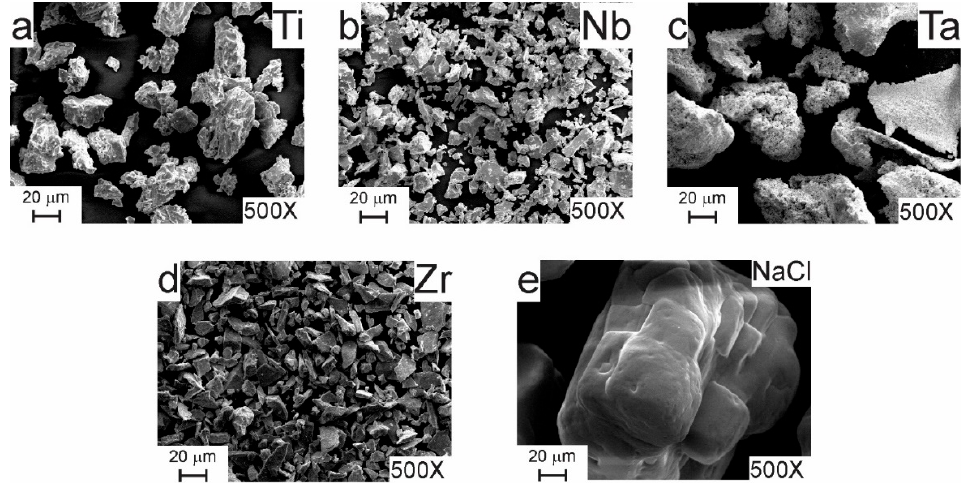
Figure 3. SEM images of as-received ( a ) Ti, ( b ) Nb, ( c ) Ta, ( d ) Zr, and ( e ) NaCl powders.